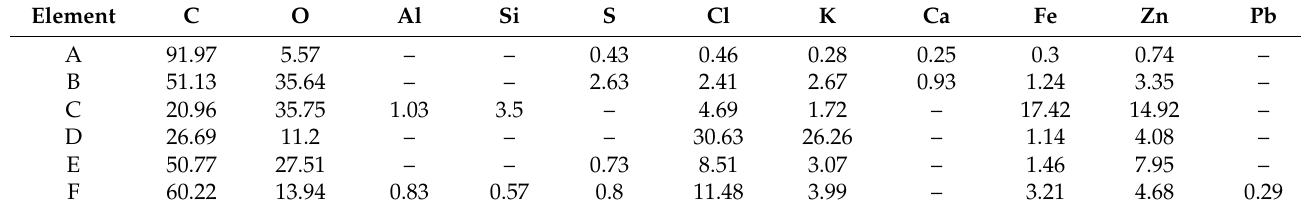
Figure 6. SEM images of the coagulum. Table 2. Element composition in marked regions of Figure 6 (mol%).